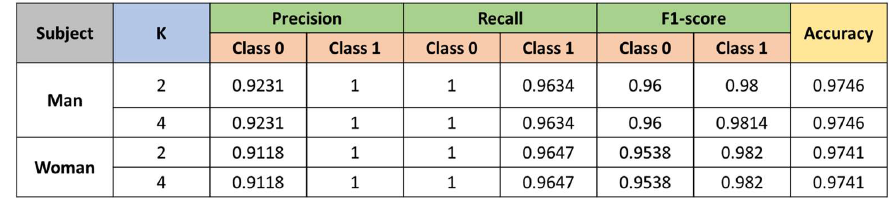
Figure 11. Results of the KNN classifier.